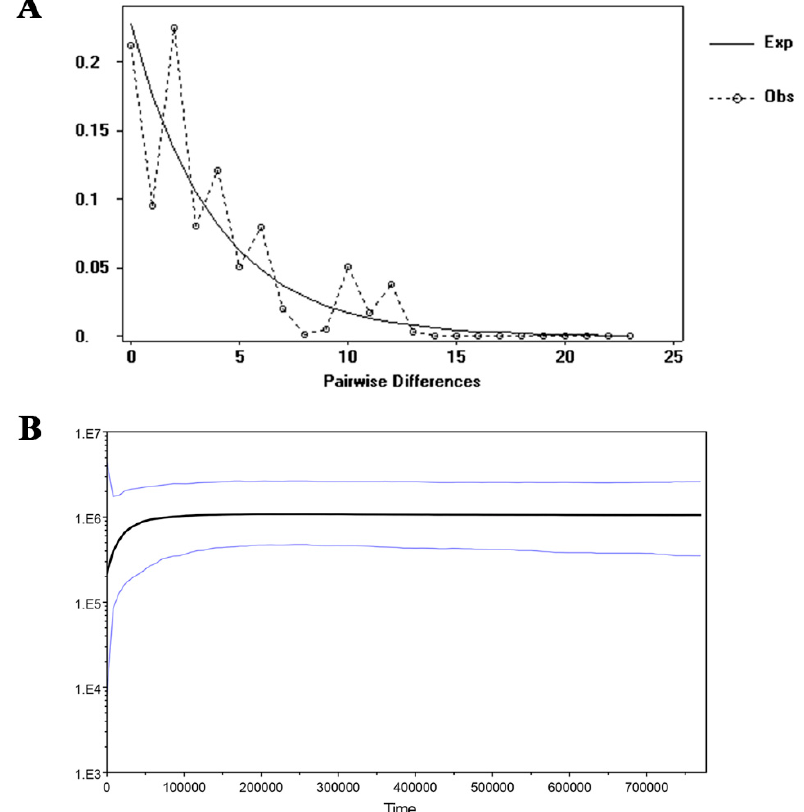
Figure 4. Mismatch distribution ( A ) and Bayesian skyline plot based on combined cpDNA sequences ( B ). ( A ) The solid lines show expected values, whereas the dashed lines represent observed values under a model of sudden population expansion. ( B ) The black line indicates effective population size fluctuation throughout.